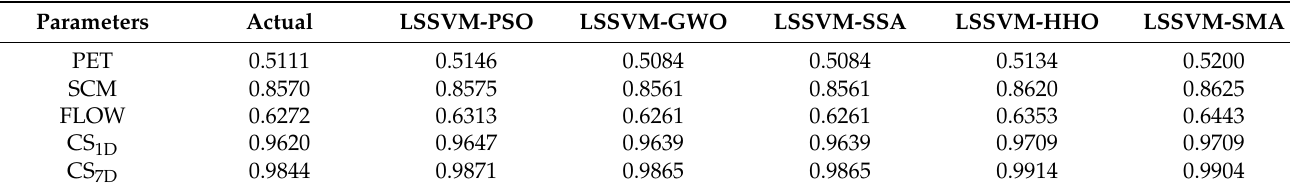
Table 8. Results of SA for the total dataset.